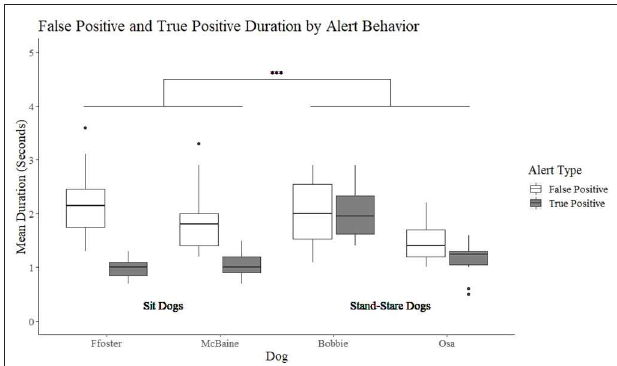
FIGURE 2 | The duration of the sit and stand-stare dogs’ true positive and false positive alerts. ***Indicates a significant difference at p <